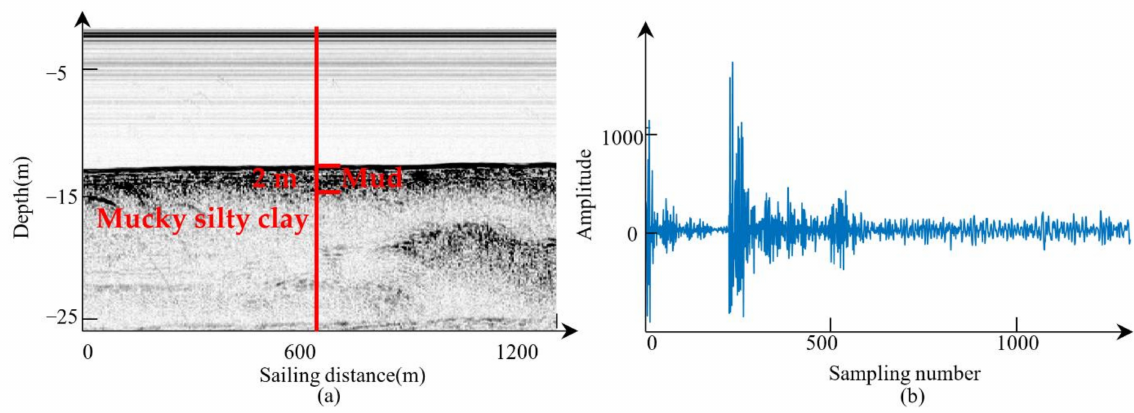
Figure 9. The measurement data. ( a ) The SBP image. ( b ) The raw data of one ping.